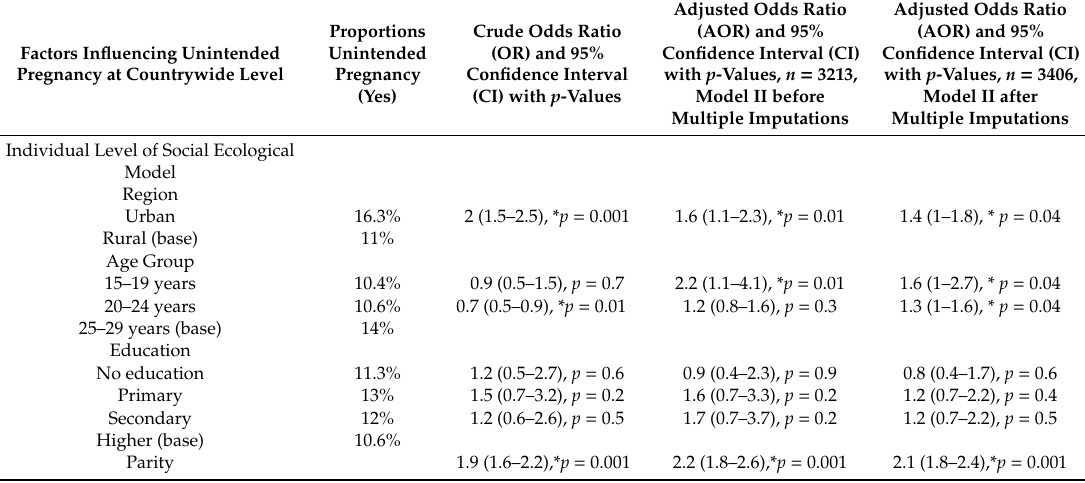
Factors Influencing Unintended Pregnancy at Countrywide Level